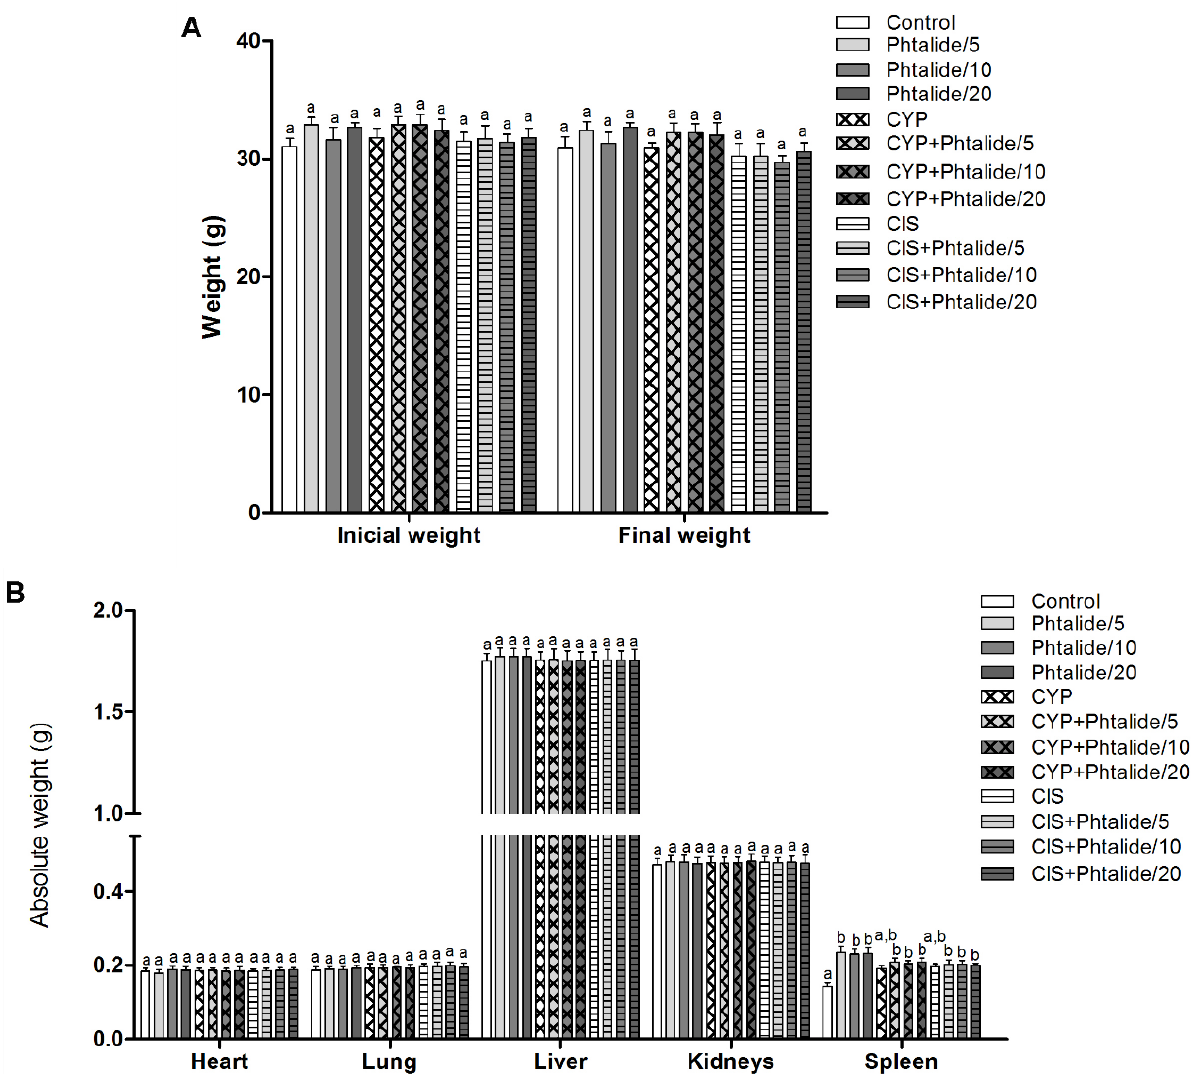
Figure 2. Biometric parameters of mice treated with Phthalide 1 . ( A ) Initial and final weight; ( B ) Absolute organ weight: Heart, lung, kidneys, liver, and spleen. Legend: g: Gram; CYP: Cyclophos- phamide; CIS: Cisplatin; Phthalide 1 : 3-heptylidene-4,6-dimethoxy-3 H -isobenzofuran-1-one; Phthalide 1 /5 – 5 mg/kg; Phthalide 1 /10 – 10 mg/kg; Phthalide 1 /20 – 20 mg/kg. Results are presented as mean ± SEM. Different letters indicate statistically significant differences (Statistical test: ANOVA/Tukey, p < 0.05). Table 1. Mean ± Standard error of initial and final weight of Swiss mice treated with different doses of 1 .